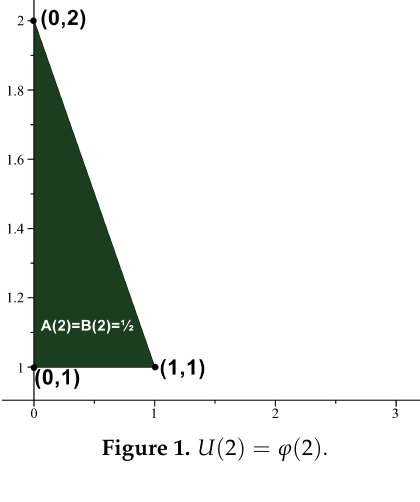
Figure 1. U ( 2 ) = ϕ ( 2 )